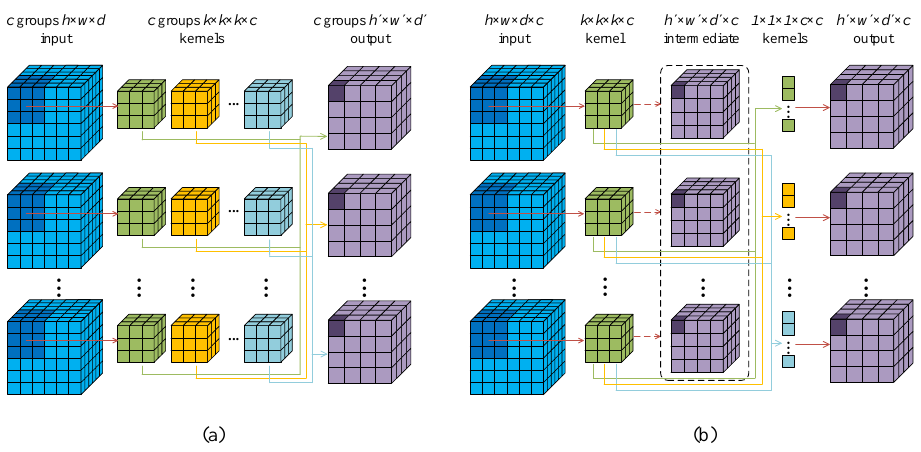
Figure 4. Illustrations of C3D and 3D-depthwise separable convolution with multi groups of kernels. Different filters are coded by different colors, and the convolution kernels within the same group are marked by the same color. ( a ) When the number of the kernels of C3D is c . ( b ) The process of 3D-depthwise separable convolution in the same situation. All 2D operations in depth separable convolution are replaced by 3D operations in (b). Firstly, doing vanilla 3D convolutions on each channel of the input with the kernel size of k × k × k (3D depthwise convolution). Then, doing c times 1 × 1 × 1 convolutions to the intermediates (3D pointwise convolution), and the output with the same size of C3D can be